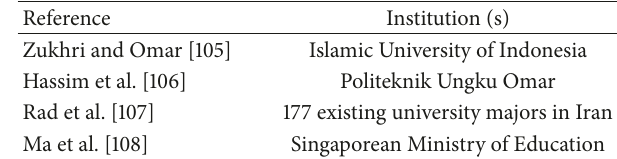
Table 14: Summary of real-world NSAP from different